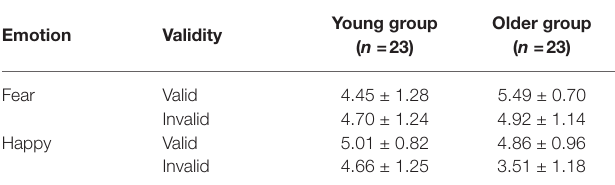
TABLE 2 | The mean values of d ' in Go/no-go tasks for both age groups (ms) ( M ± SD